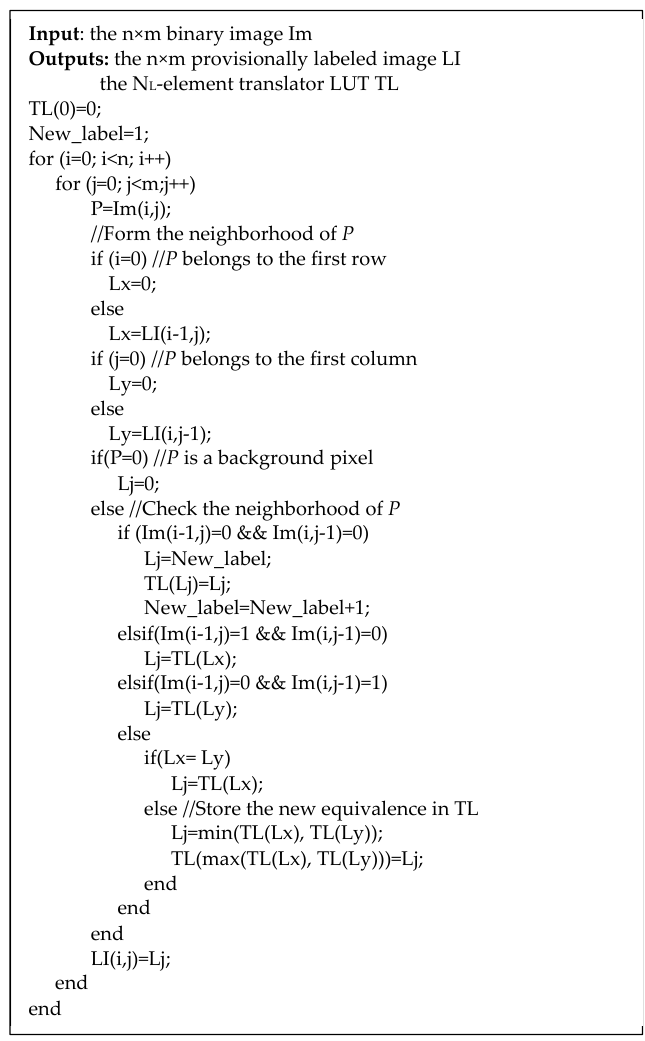
Figure 6. Pseudo-code of the proposed labeling technique.